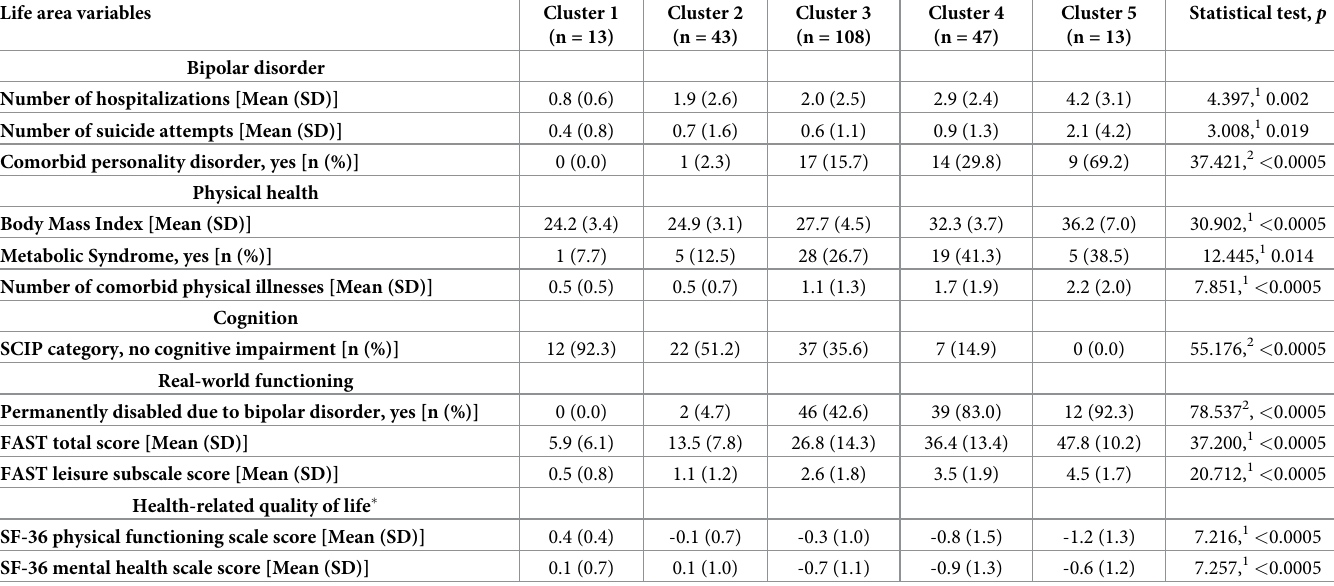
Table 4. Values and distribution of variables in the classification across the five proposed clusters. Life area